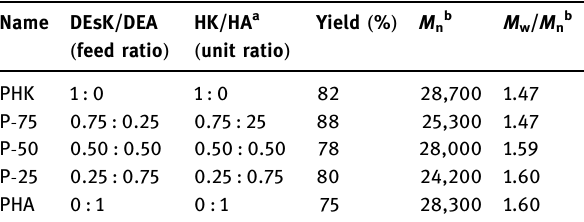
Table 1: E ff ect of the monomer ratio on the copolymerization of DEK, HDO, and DEA